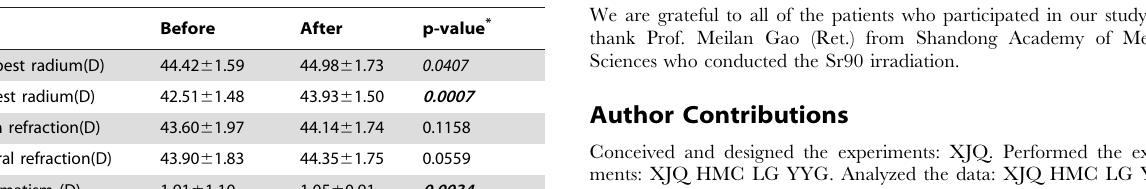
Figure S1 Mimic picture of the applicator.